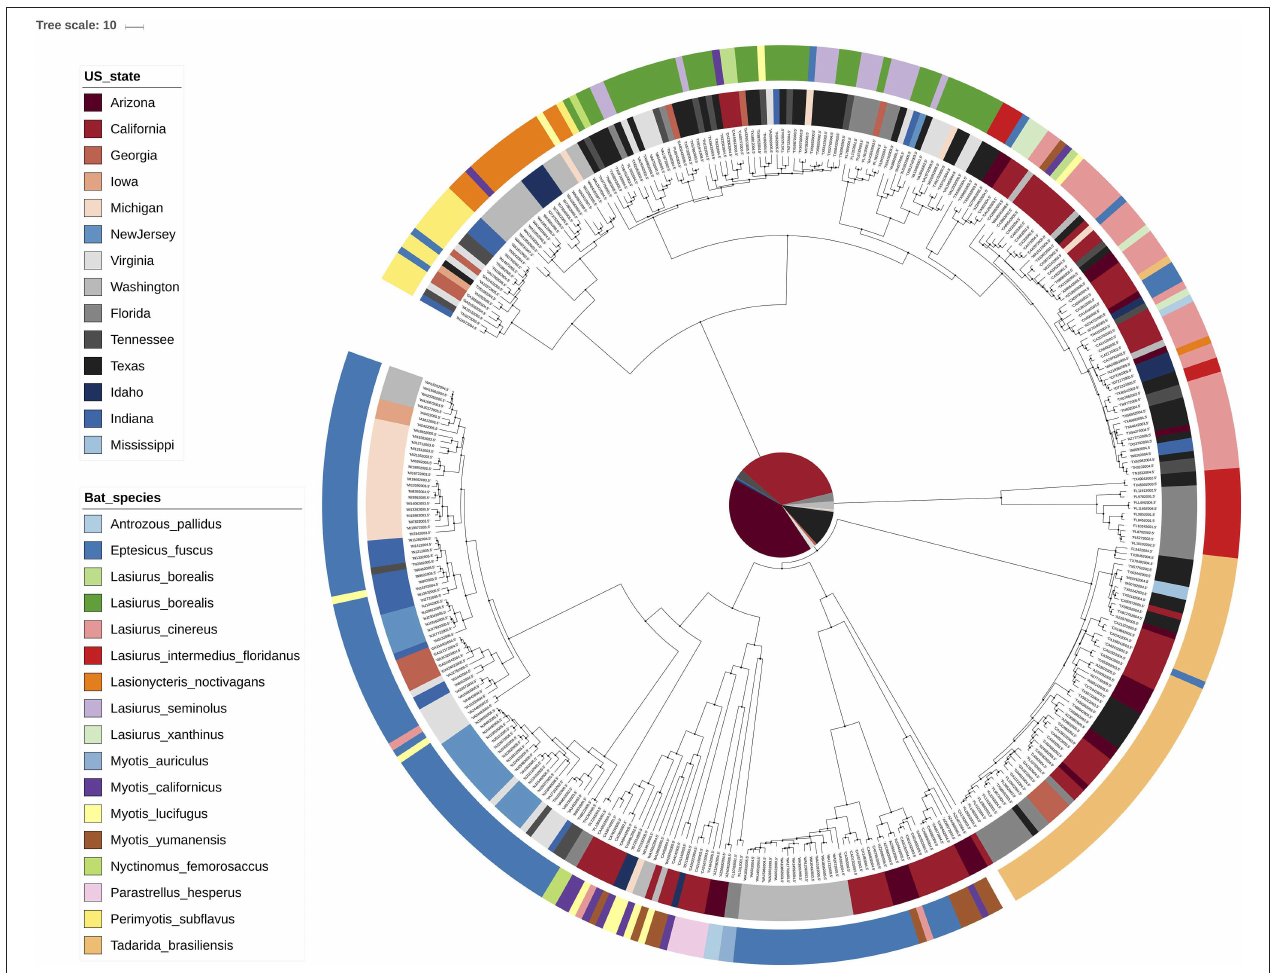
FIGURE 2 | Interactive tree of life [iTOL; (18)] visualization of the MCC tree for RABV. Rather than exploiting the annotations within an MCC tree, iTOL allows importing external text files with annotations through an easy drag-and-drop interface. We have here colored the tip nodes according to the bat host species (outer circle) as well as the sampling location (inner circle) corresponding to each sample. Many visual aspects can be set this way and an extensive online help page is